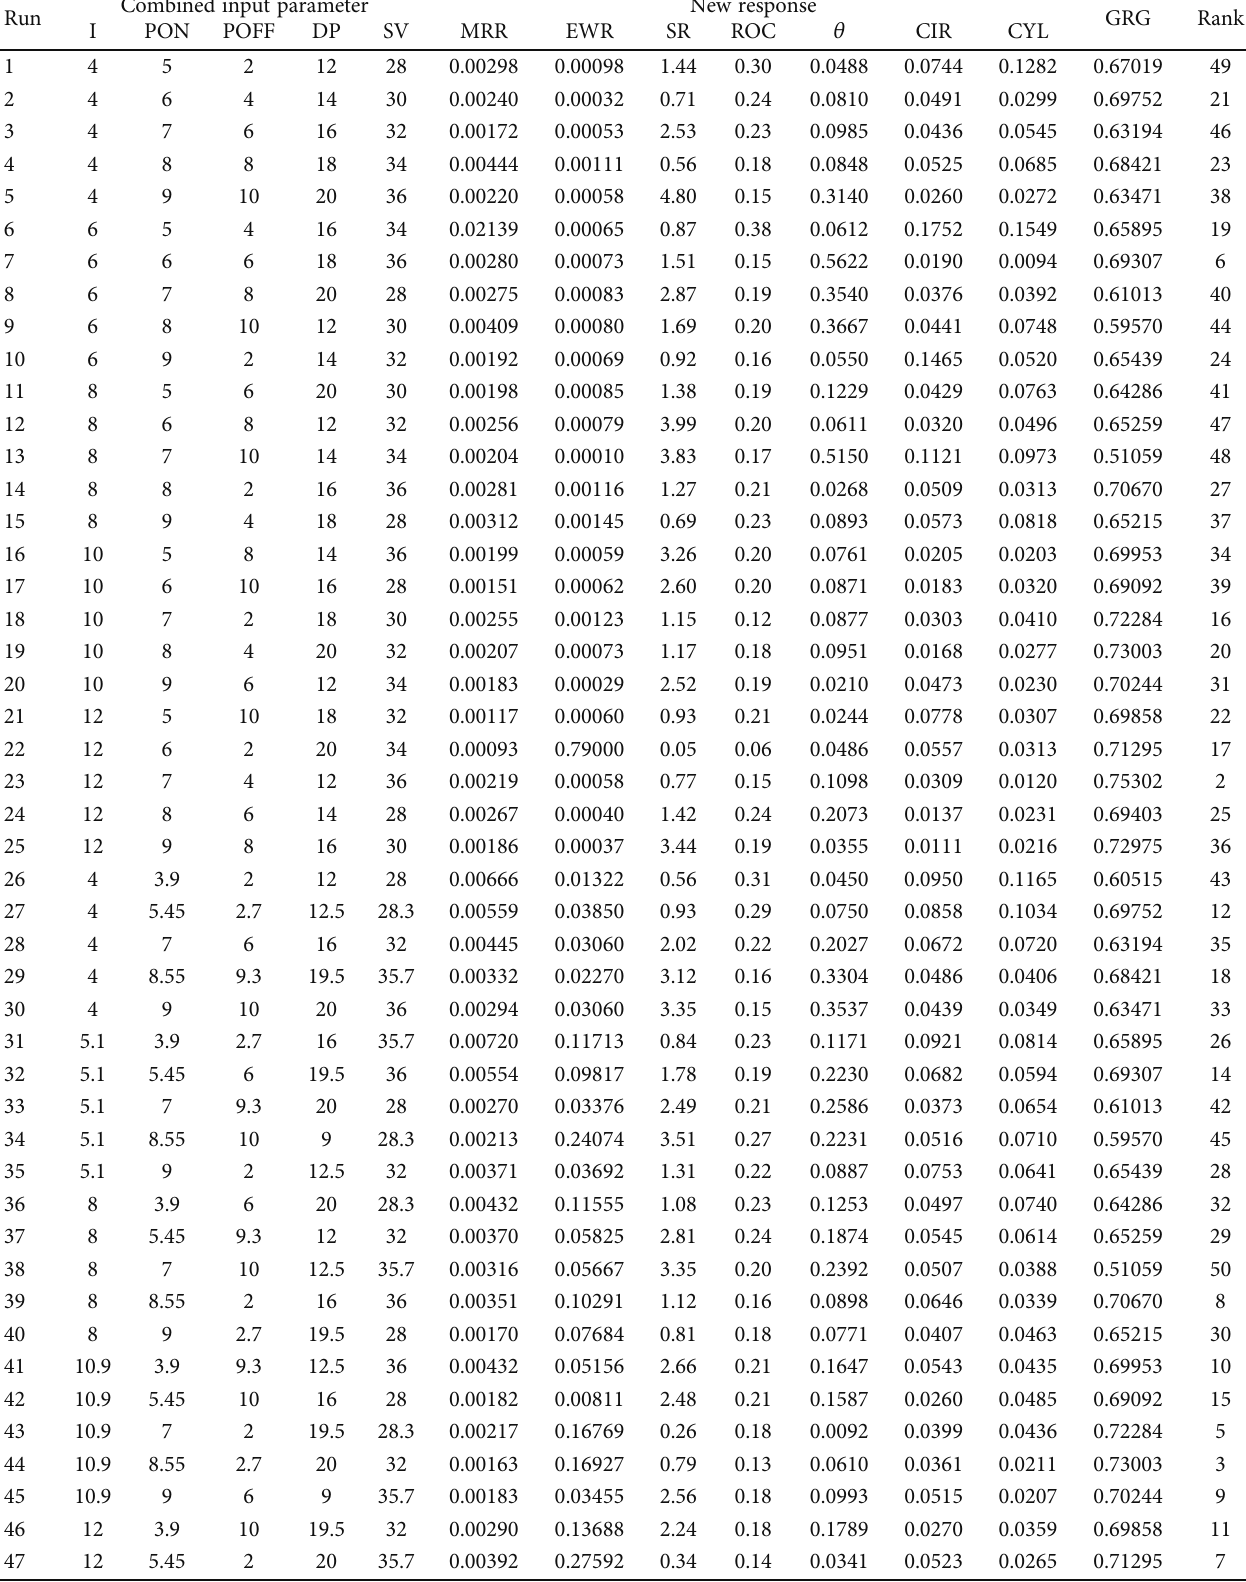
Table 10: Combined